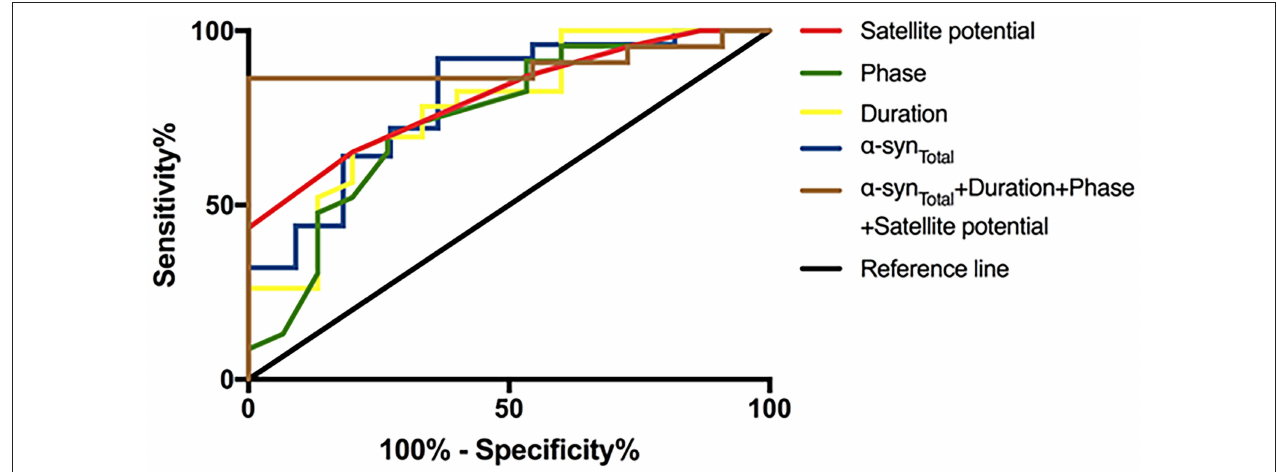
FIGURE 3 | ROC curve of α -syn Total in salivary EVs and indexes of EAS-EMG (including duration, phase and satellite potential) between MSA-P and PD. The red curve, green curve, yellow curve, blue curve, and brown curve represent satellite potential, phase, duration, α -syn Total , and integrative model.